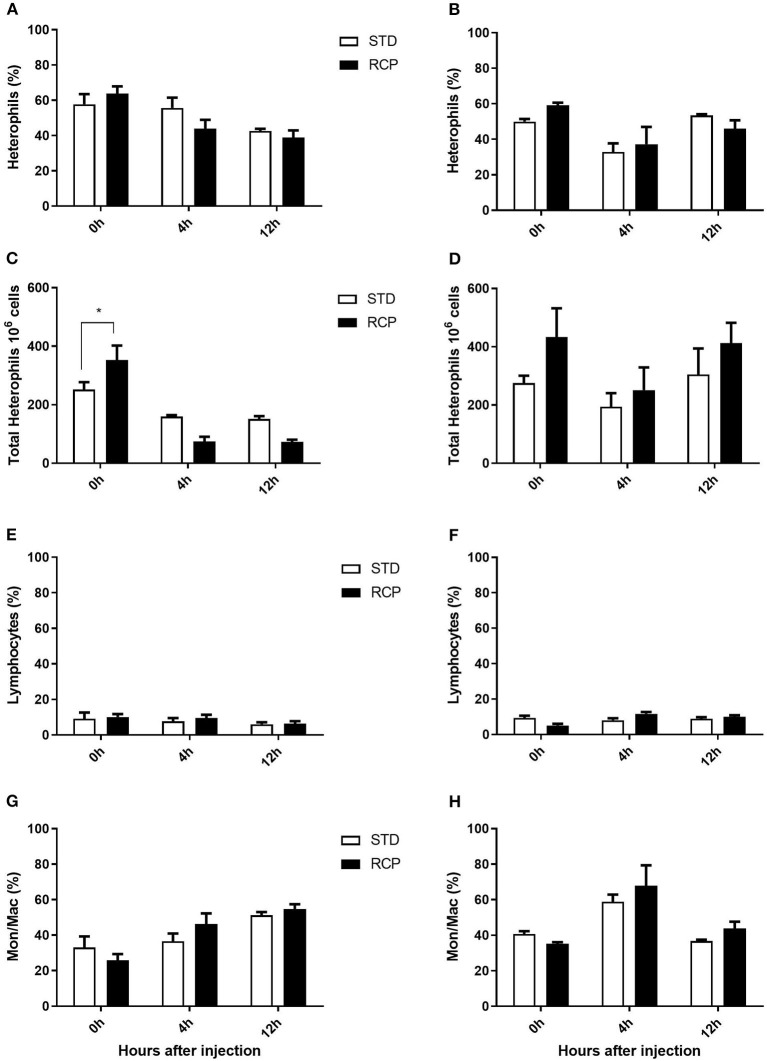
Impact of reduced crude protein diet on heterophil, lymphocyte, and monocyte/macrophage on bone marrow leukocyte composition following an in vivo zymosan challenge. Bone marrow leukocyte subpopulation after 0, 4, and 12 h post intra-abdominal administration of zymosan (2.5 mg). Changes to bone marrow heterophil percentages [d 14 (A); d 35 (B)] and absolute numbers [d 14 (C); d 35 (D)]. Parallel changes to the percentage of lymphocytes d 14 (E) and d 35 (F), and monocyte/macrophages d14 (G) and d 35 (H). *P < 0.05 between different treatments. RCP, Reduced Crude Protein; STD, Standard diet; n = 5.